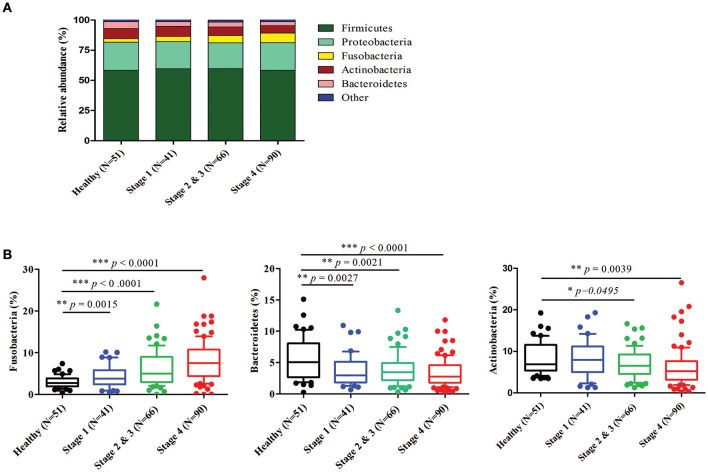
Relative abundance of different bacteria phyla in healthy and OSCC patients. Bacteria taxonomic profiling at the phylum level of oral microbiome from healthy controls and OSCC patients. (A) The five most abundant bacteria phylum in the oral microbiome. (B) Box plots show the relative abundance of Fusobacteria, Bacteroidetes, and Actinobacteria in healthy and OSCC patients. Horizontal lines represent mean values. p < 0.05 indicates statistical significance using a nonparametric Mann-Whitney U test.